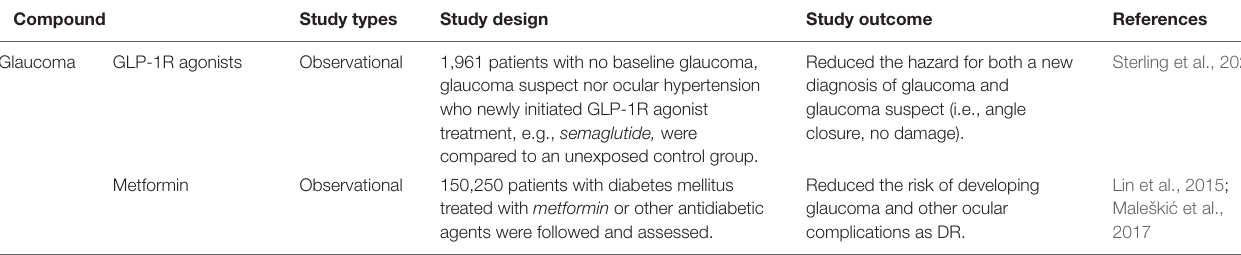
TABLE 3 | Clinical studies elucidating the use of antidiabetics against